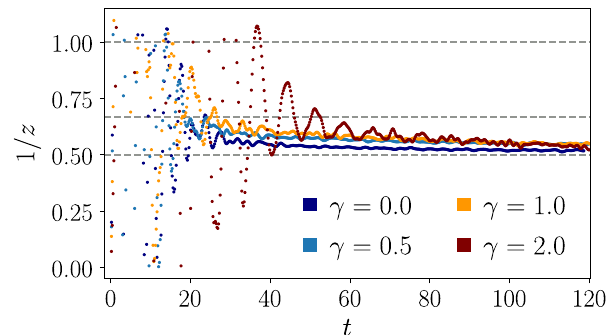
FIG. 12. Instantaneous dynamical exponent in the PPXPP model with various strengths of the PPNPP deformation. We observe clearly different behavior from the PXP þ PNP model with energy diffusion being observed for all values of the PPNPP deformation parameter. Data obtained with bond dimension χ ¼ 256 and system size N ¼ 1024